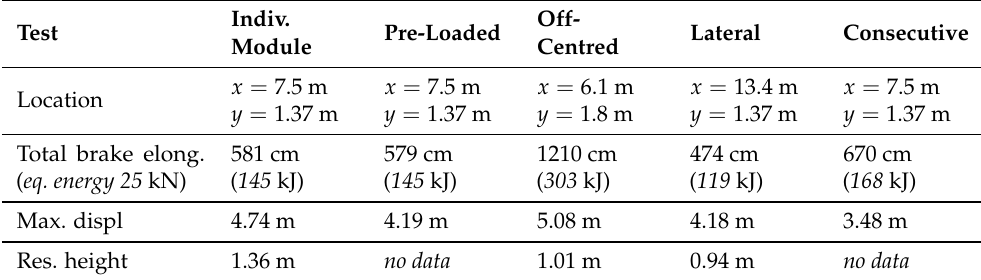
Table 2. Characteristics recorded for each of the five test impacts for the second campaign.